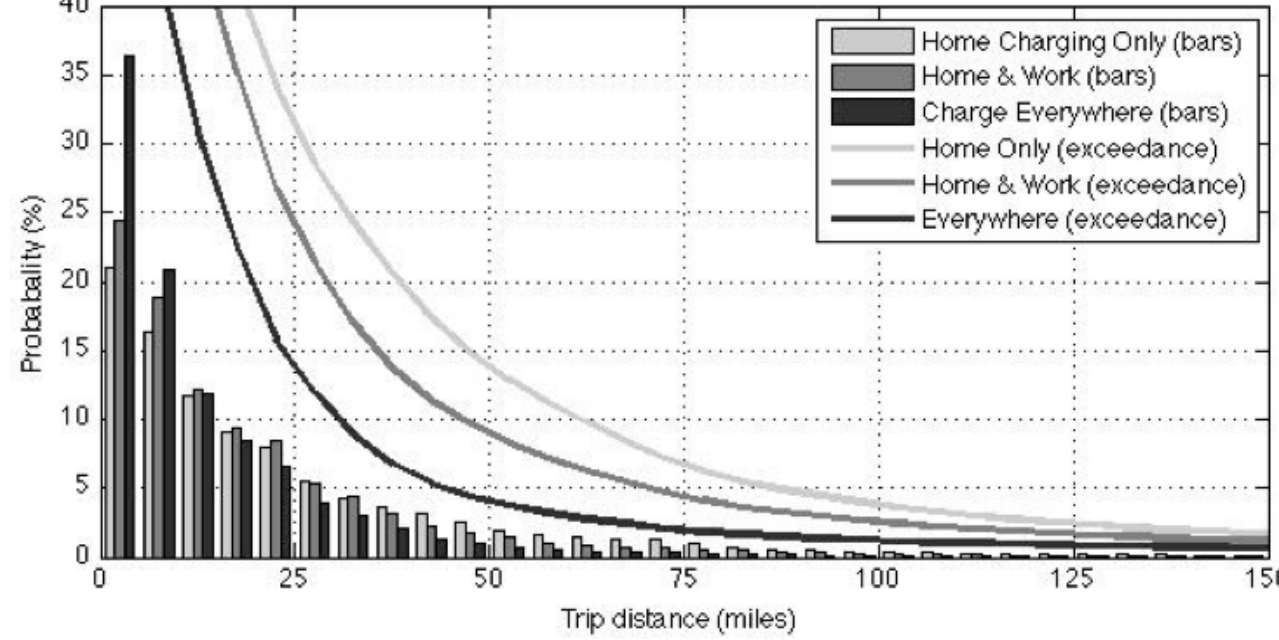
Figure 4. Distribution of distances of trip chains (EVSE to EVSE) in the trip inventory, comparing the three definitions of charging locations. Reprinted by permission, from Pearre [24].